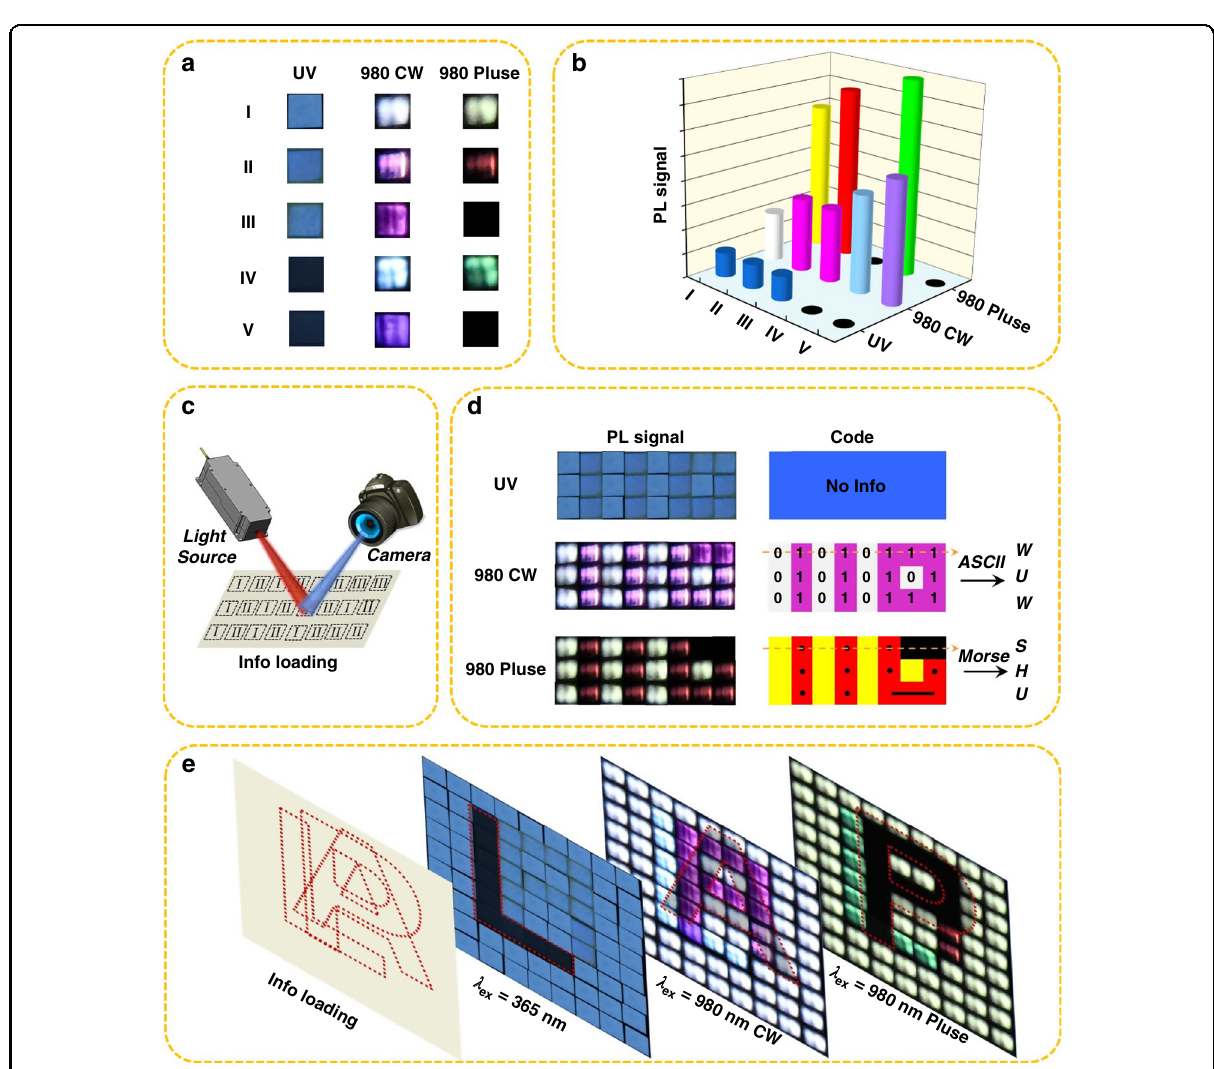
Fig. 4 Loading and decoding of optical information. a Photos of different nanomaterials coated on a paper (1 × 1 mm) under illumination of UV Lamp (365 nm, 80 mW cm -2 ), 980 nm continuous wave (980 nm CW, 10 W cm -2 ) and 980 nm pulsed wave (980 nm Pulse), respectively. (I: